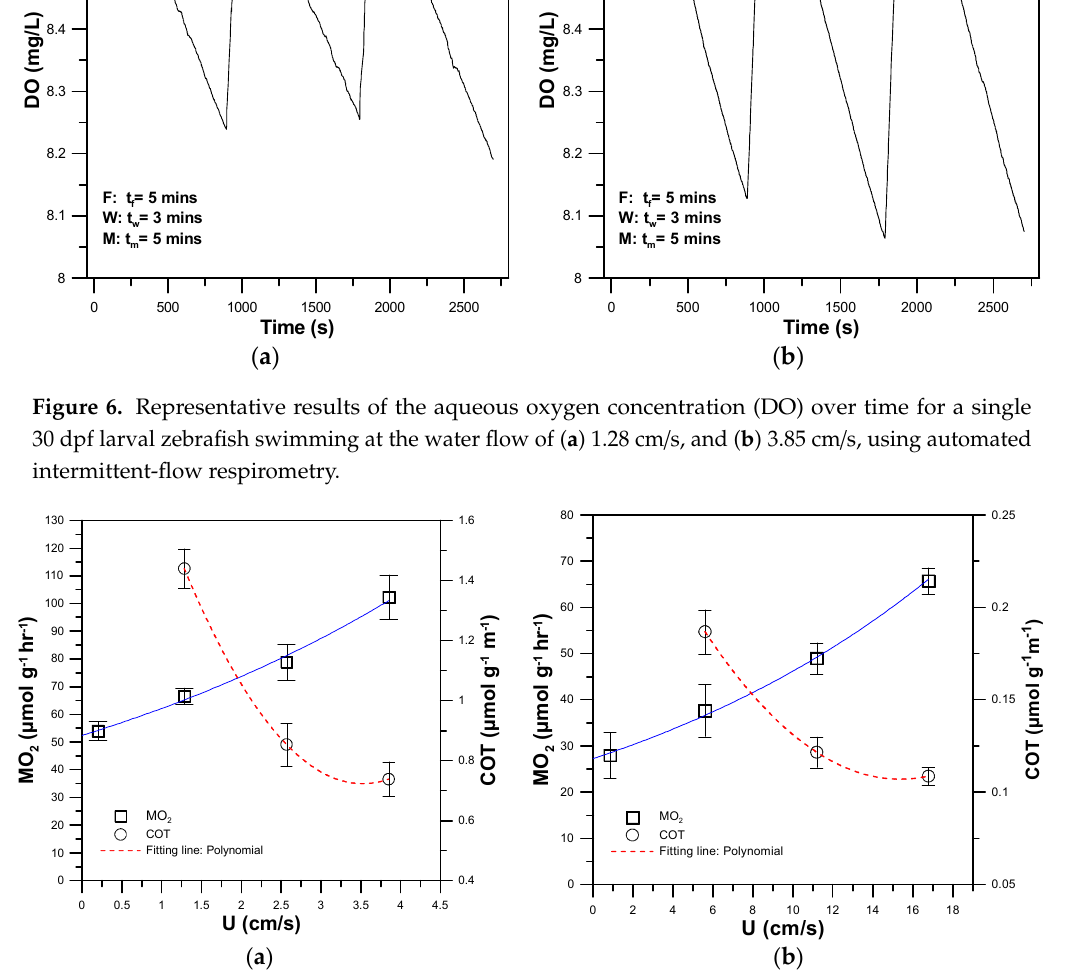
Figure 7. The metabolic rate (MO 2 ) (white squares and solid blue line) and COT (white circles and broken red line) of single ( a ) 30 and ( b ) 90 dpf zebrafish swimming at 5, 35, 70 and 100% U crit , respectively. (Mean ± SEM; n = 9).